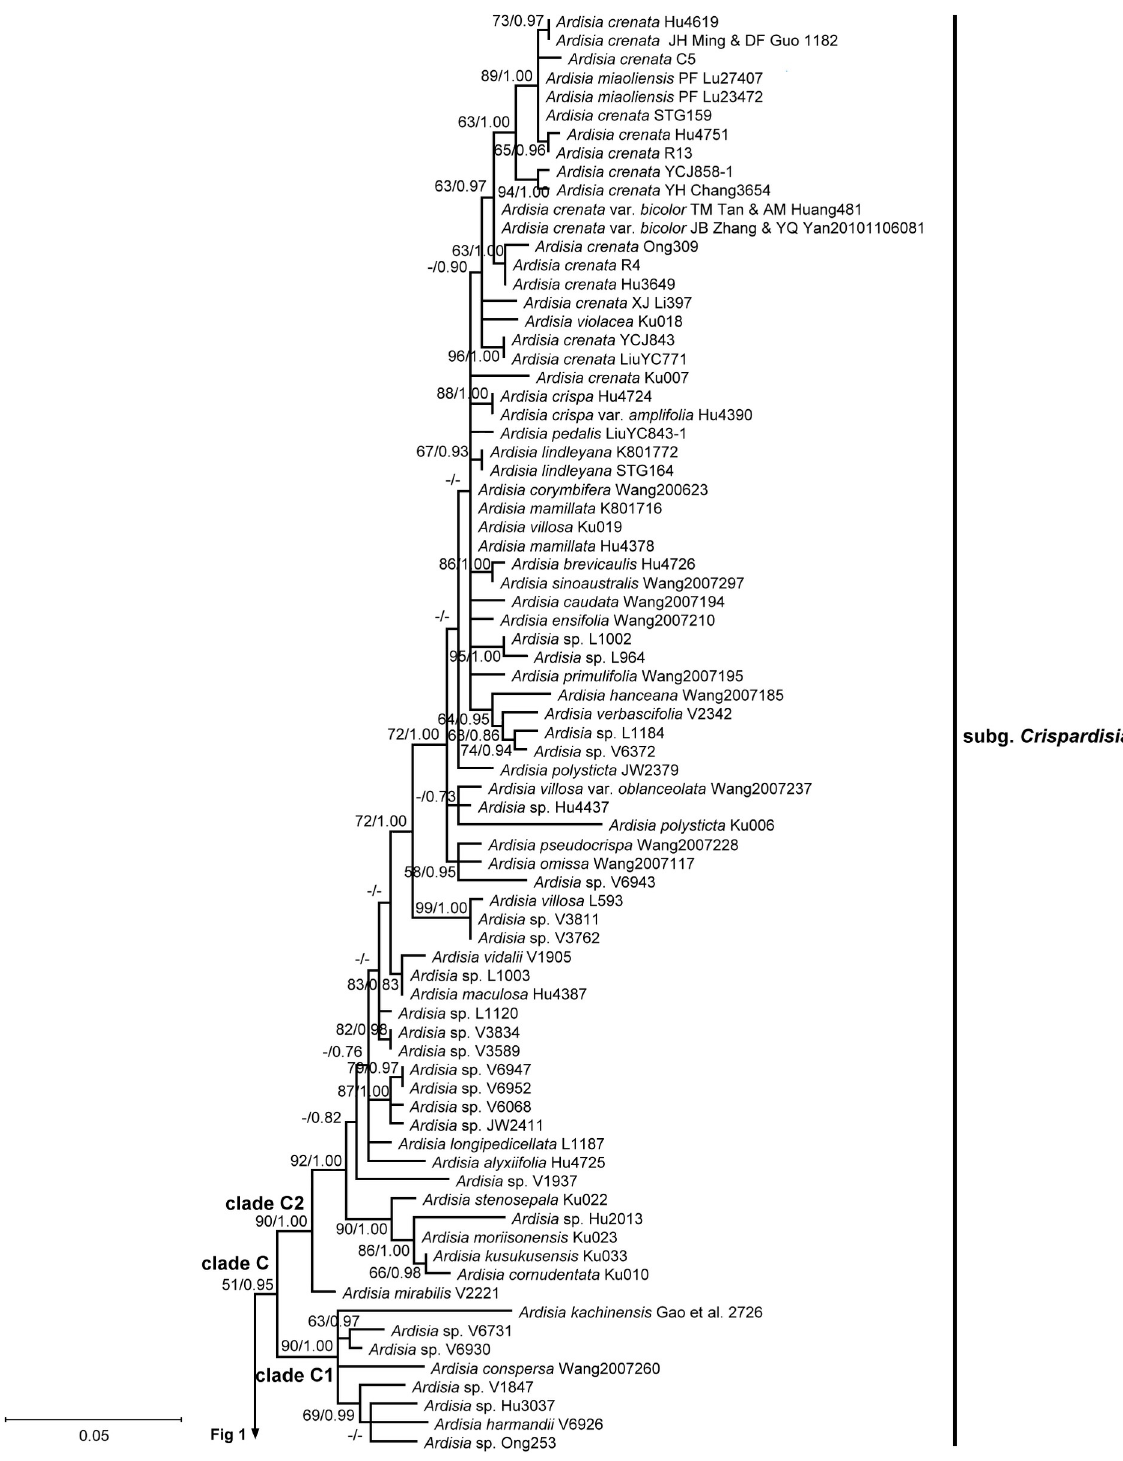
Fig 2. Phylogeny of Ardisia and allies inferred using maximum likelihood (ML) based on nuclear ITS sequences. Upper half of the tree. Numbers at branches are ML bootstrap support (ML BP) values and Bayesian posterior probabilities (BI). ML bootstrap support values are indicated only if at least 50, and the Bayesian posterior probabilities are indicated only if at least 0.7. Alternative branching between the two different analyses is showed as no support at the branch. Non- Ardisia species nested within the Ardisia generic complex are shown in boldface. Arrows indicate the presumed misidentification. Collection numbers (or other voucher information) are labeled after species names.